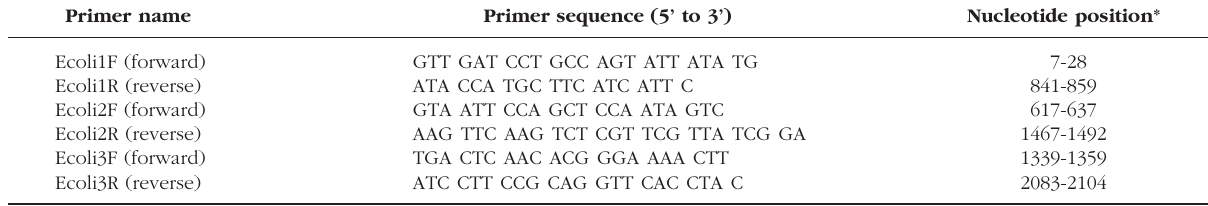
Table I. – Oligonucleotide primers used for PCR assays in present